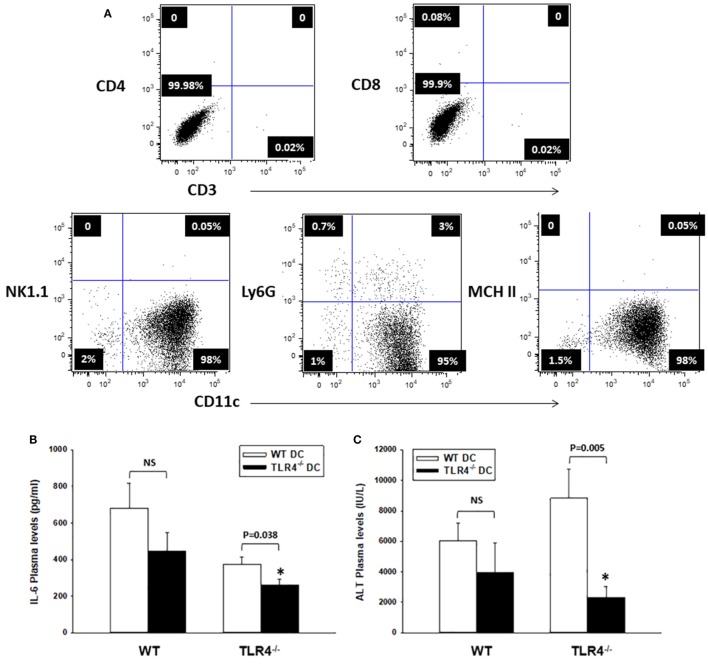
CD11c-dendritic cell (DC) contribute to systemic inflammation and liver damage after HS/T. (A) Flow cytometric analysis of TLR4−/− DC generated from bone marrow precursors (day 6), purified by sorting with CD11c paramagnetic beads (Myltenyi), and adoptively transferred (i.v.) to TLR4−/− [or wild-type (WT), control] B6 mice. The injected inoculum consisted mostly of immature DC (purity >95%). (B,C) TLR4−/− B6 mice adoptively transferred (i.v.) with TLR4−/− DC exhibited significantly lower concentrations of IL-6 and ALT in plasma measured 6 h after HS/T, as compared to TLR4−/− mice injected with WT DCs. There were no significant differences in plasma concentrations of IL-6 and ALT following HS/T in WT B6 mice reconstituted (i.v.) with either WT or TLR4−/− DCs (B) *P < 0.05, analyzed by Student’s t-test; (C) *P < 0.05, analyzed by Mann–Whitney Rank Sum Test (n = 8–12 independent experiments).